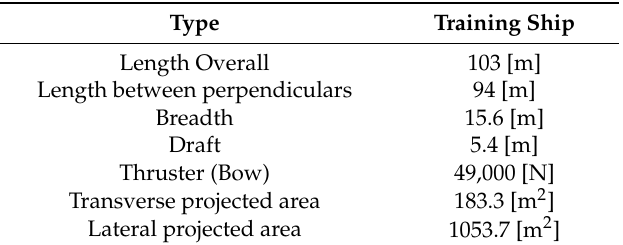
Table 1. Principle ship